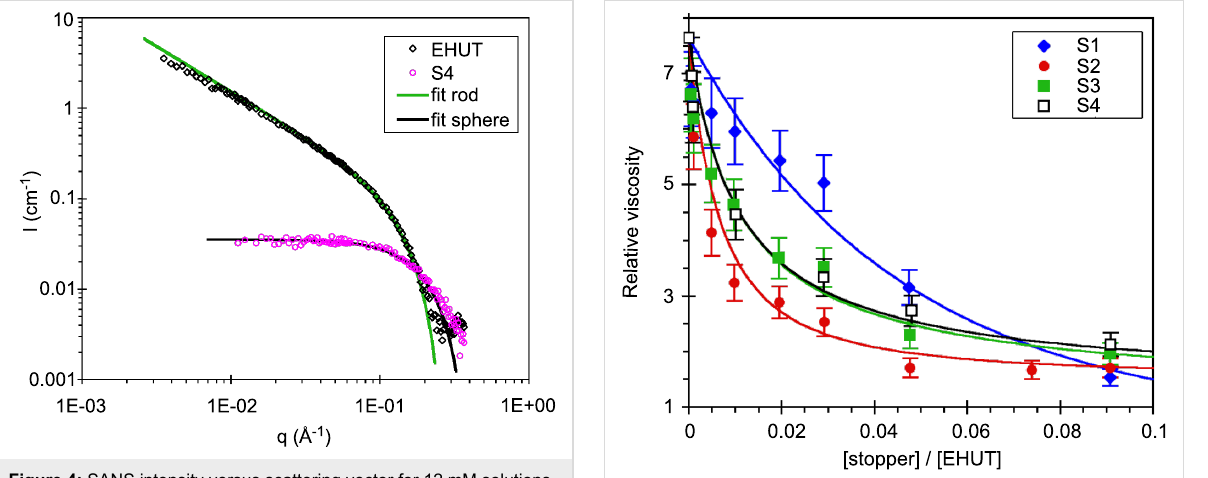
Figure 4: SANS intensity versus scattering vector for 12 mM solutions of EHUT or S4 in d 8 -toluene, at 22 °C. The plain curves are fits according to a model for infinitely long rigid rods of diameter 26 Å (green), or for spheres of diameter 22 Å (black).